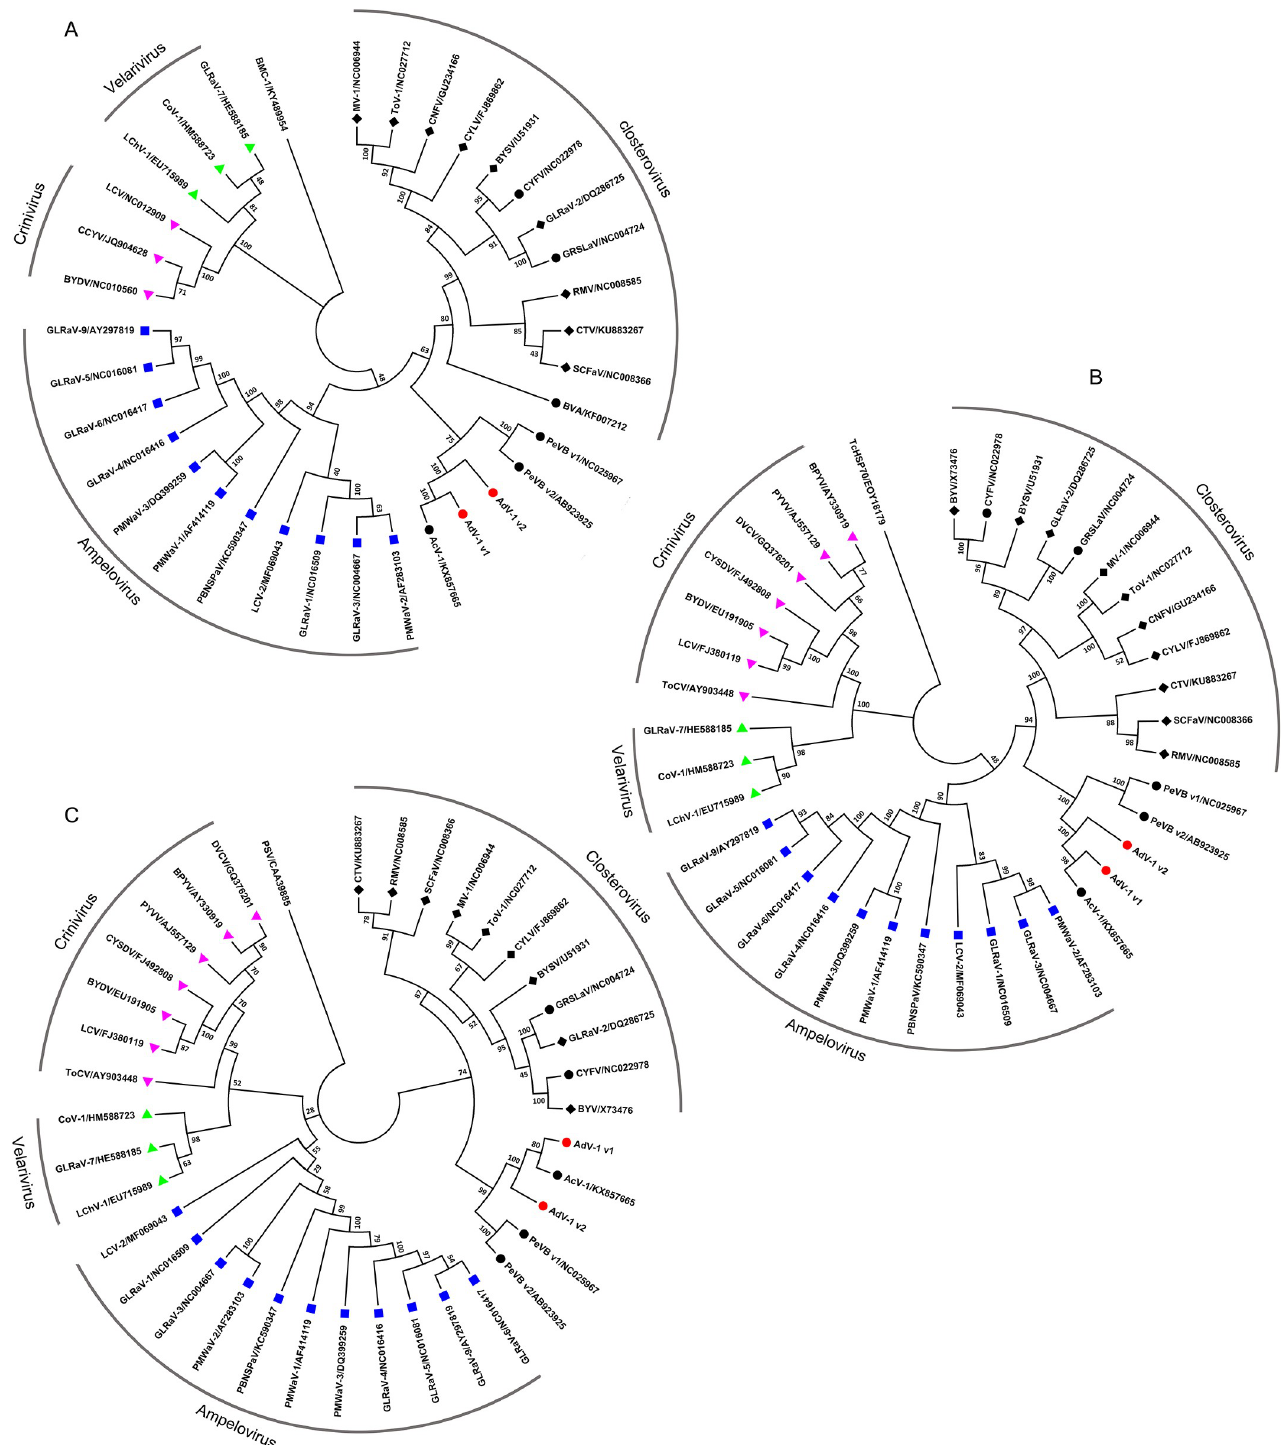
Fig 3. Phylogenetic trees of the amino acid sequences of RdRp (A), HSP70h (B), and CP (C) from representative members of the family Closteroviridae . Bipolaris maydis chrysovirus 1 RaRd (BMC-1 in A), Theobroma cacao HSP70 (TcHSP70 in B), and Peanut stunt virus CP (PSV in C) were used as outgroups. Bootstrap support values are displayed at nodes. Virus names and their abbreviations were Actinidia virus 1 (AcV-1), Persimmon virus B variant 1 and 2 (PeVB v1 and PeVB v2), Blueberry viru s A (BVA), Grapevine rootstock stem lesion associated virus (GRSLaV), Carnation yellow fleck virus (CYFV), Mint virus 1 (MV- 1), Carnation necrotic fleck virus (CNFV), Tobacco virus 1 (ToV-1), Ctrawberry chlorotic fleck associated virus (SCFaV), Beet yellow stunt virus (BYSV), Citrus